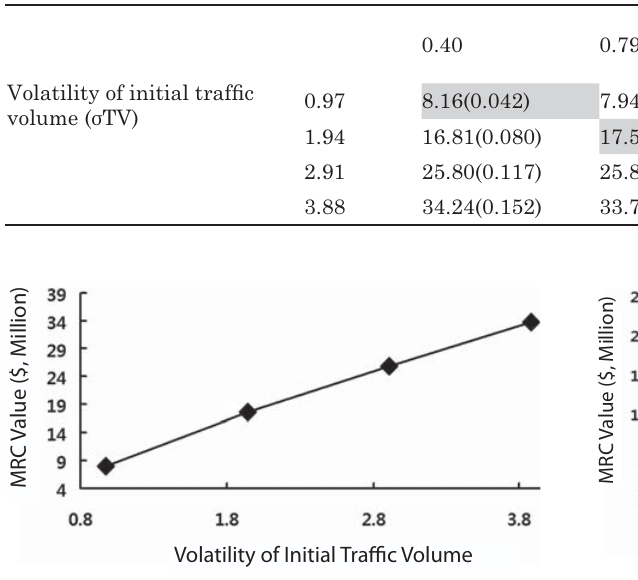
Figure 6 . MRC value over revenue cap level (MRG: